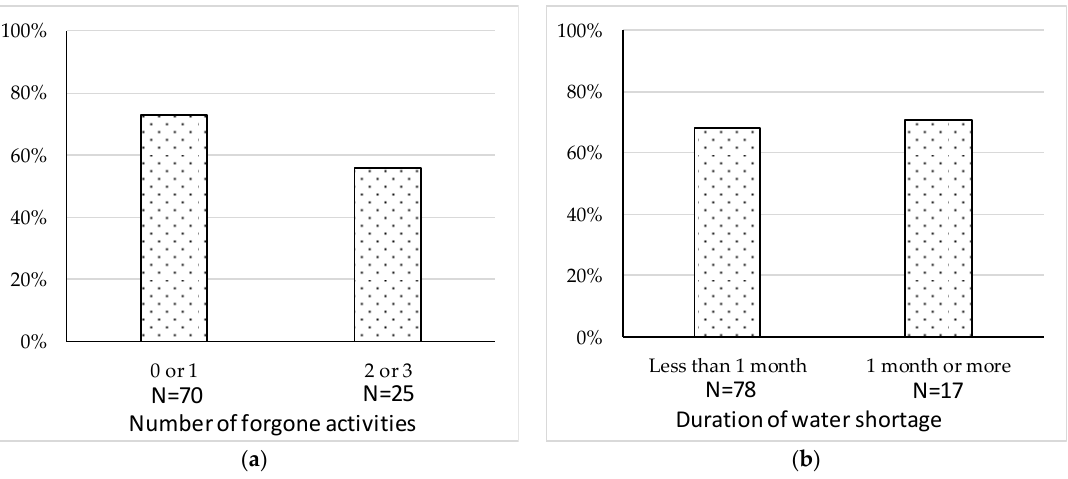
Figure 6. Water-shortage experience and perception of natural water as adequate emergency water supply: ( a ) Number of forgone activities; ( b ) Duration of water shortage.